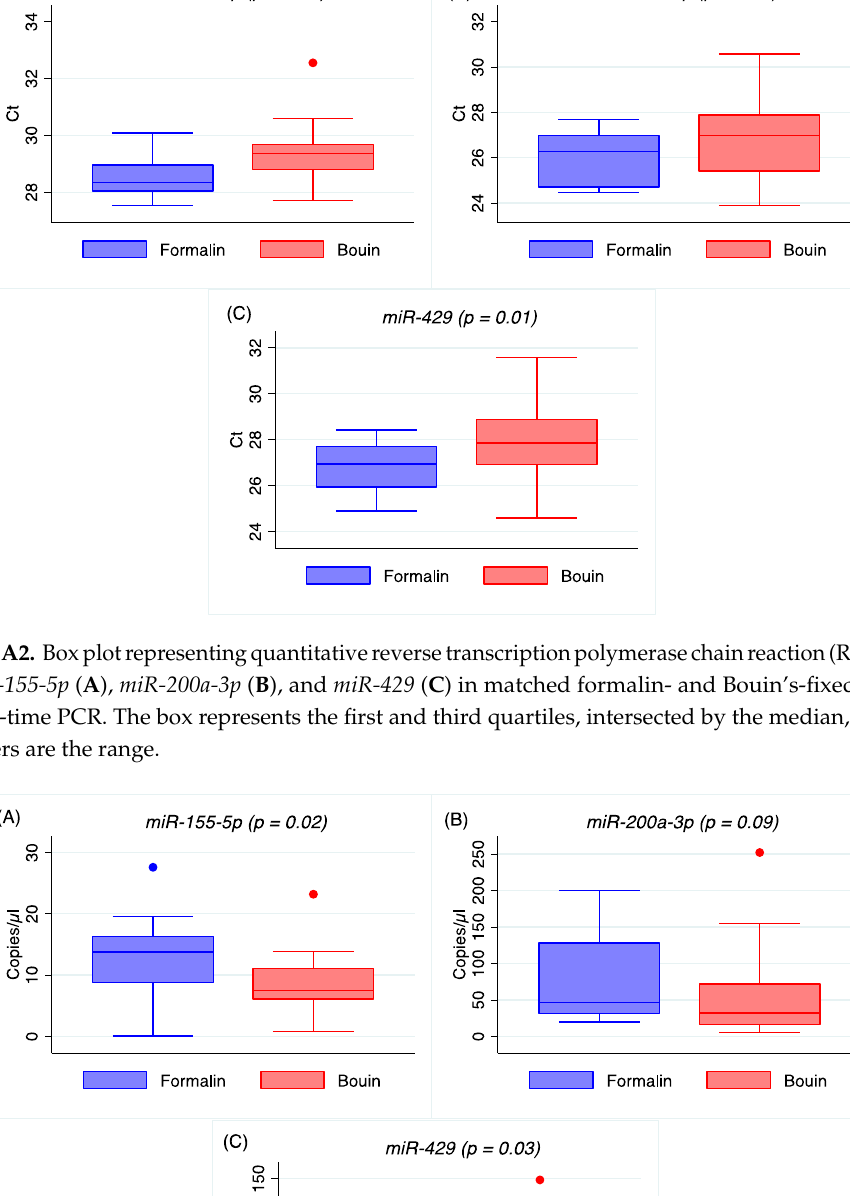
Figure A1. Box plot representing the relative amount of RNA stretches of ( A ) 60–149 nucleotides and ( B ) 150–299 nucleotides in matched formalin- and Bouin’s solution-fixed samples. The box represents the first and third quartiles, intersected by the median, and the whiskers are the range.